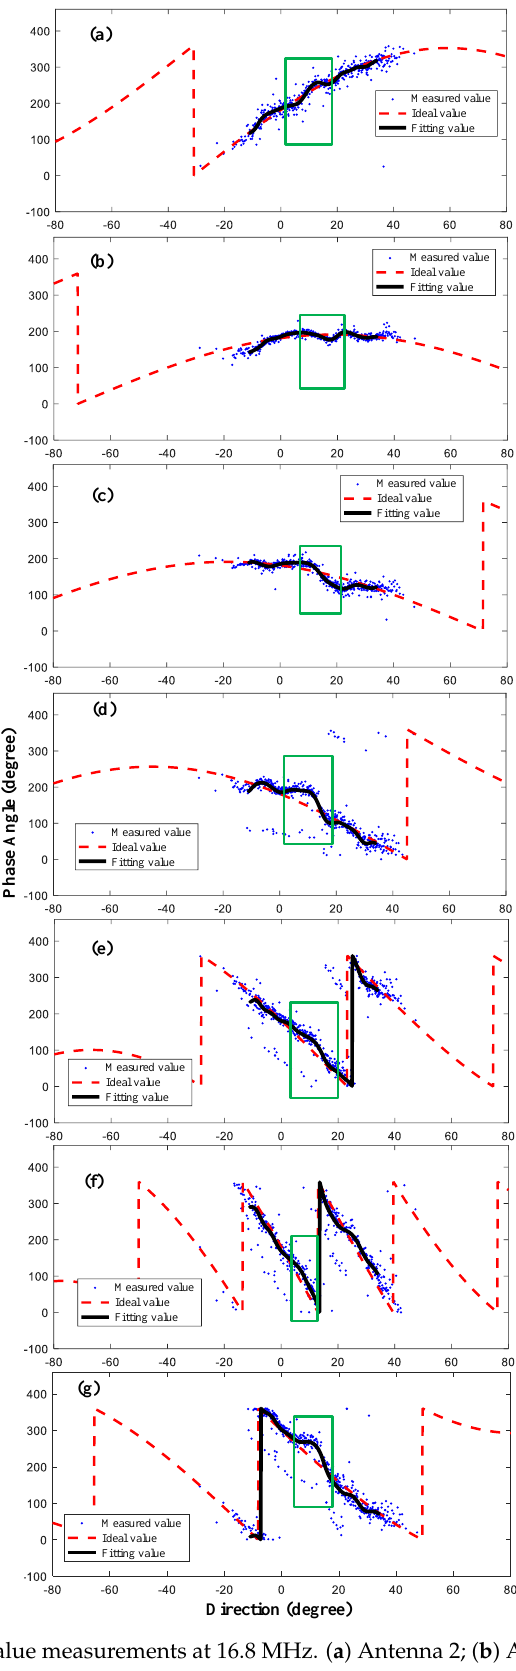
Figure 7. Array phase value measurements at 16.8 MHz. ( a ) Antenna 2; ( b ) Antenna 3; ( c ) Antenna 4; ( d ) Antenna 5; ( e ) Antenna 6; ( f ) Antenna 7; ( g ) Antenna